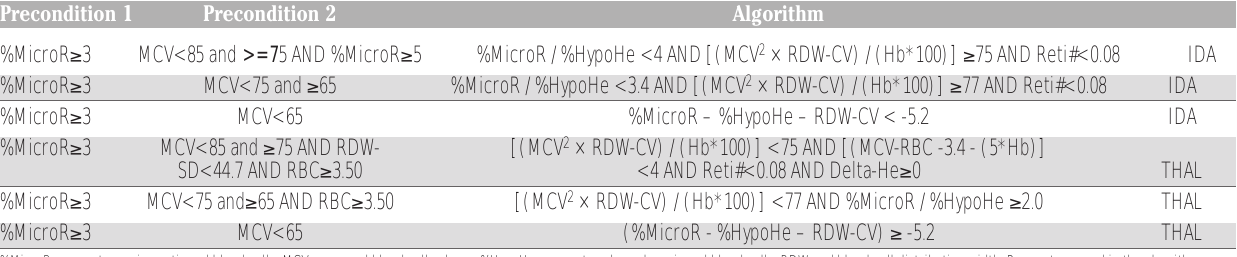
Table 2. Preconditions and algorithms for discrimination microcytic anemia on iron deficiency anemia (IDA) and beta-thalassemia (THAL). Precondition 1 Precondition